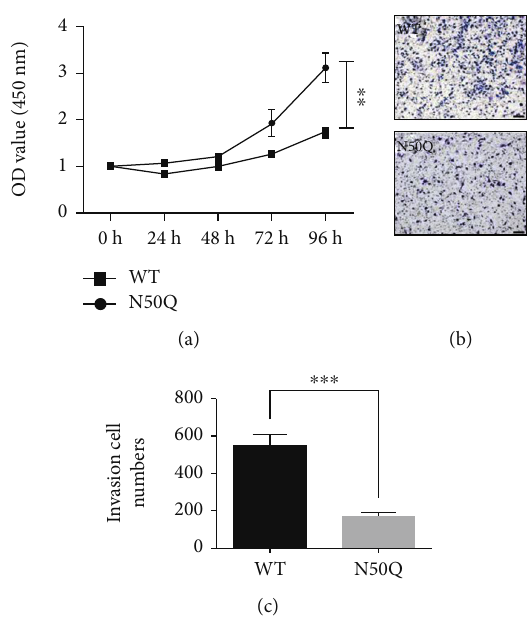
Figure 5: Elimination of N-glycans at Asn50 inhibits cell proliferation and metastasis. (a) The proliferation ability of glioma cells was detected by CCK8 assay performed on both wild-type SND1-EGFP and N50Q-EGFP overexpressing cells with a duration of 4 days. (b) The cell invasion assay was detected by transwell assay administrated in the wild-type SND1-EGFP and N50Q-EGFP overexpressing cells, and invaded cells were fi xed and stained with 0.5% crystal violet. Scale bar: 100 μ m. (c) Representative images of the bottom surface were captured using a phase-contrast microscopy (upper). The numbers of migrated cells in nine random microscopic fi elds ( × 200) were counted and averaged. Data represent the mean ± SEM of three independent experiments. ∗ p < 0 : 01 ; ∗∗ p < 0 : 001